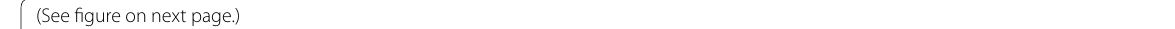
figure on next Fig. 7 Strain and ΔCFS by dike intrusion and faulting. a Dilatation by the Eq1 faulting at the depth of 0 km. Red and blue arrows denote the theoretical extensional and compressional strain axis, respectively, which were calculated from the dike intrusion and faulting model. The white bold rectangle shows the fault of the Eq1. b ΔCFS at the depth of 15 km by the Eq1. c The same as a but for the 2002 afterslip. The notation at the right side of the panel shows the parameter of the receiver-side fault, which was used for the calculation of the ∆CFS. d The same as b but for the 2002 afterslip. e The same as a but for the SW1. The fault parameters (strike, dip, length, width, and degrees of intrusion) are the same as the SW2. The white circles show the epicenters of earthquakes ( M > 2.0 and depth < 30 km) that occurred on October 2002. The black solid line shows the dike of the SW1. f The same as b but for the SW1. The white solid line shows the dike of the SW1. g The same as a but for the SW2. The open circles show the epicenters of earthquakes ( M > 2.0 and depth < 30 km) that occurred on April 2013. The black solid line shows the dike of the SW2. h The same as b but for the SW2. The white solid line shows the dike of the